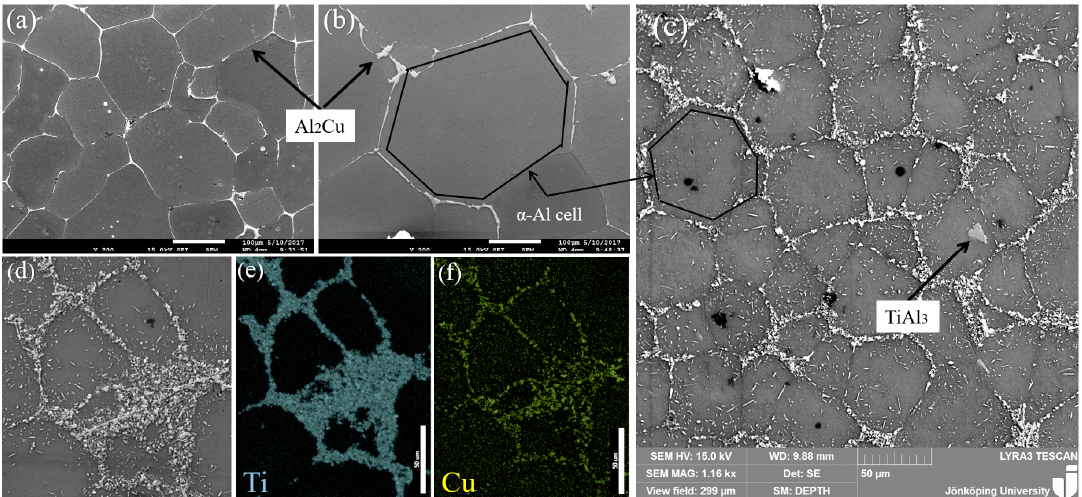
Figure 3. SEM micrographs of Al-Cu alloy cast at ( a ) 0.3 mm s − 1 and ( b ) 0.03 mm s − 1 solidification rates. ( c ) Micrographs of the A205 alloy. ( d – f ) Concentration map of Cu and Ti in the inter-dendritic region of the A205 alloy.